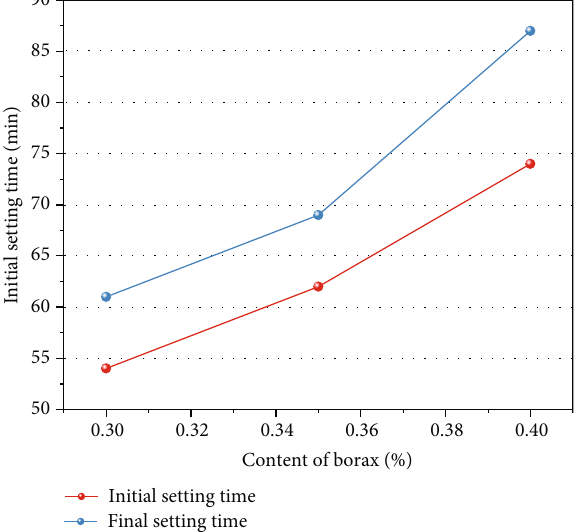
Figure 17: E ff ect of di ff erent dosages of borax on setting time.